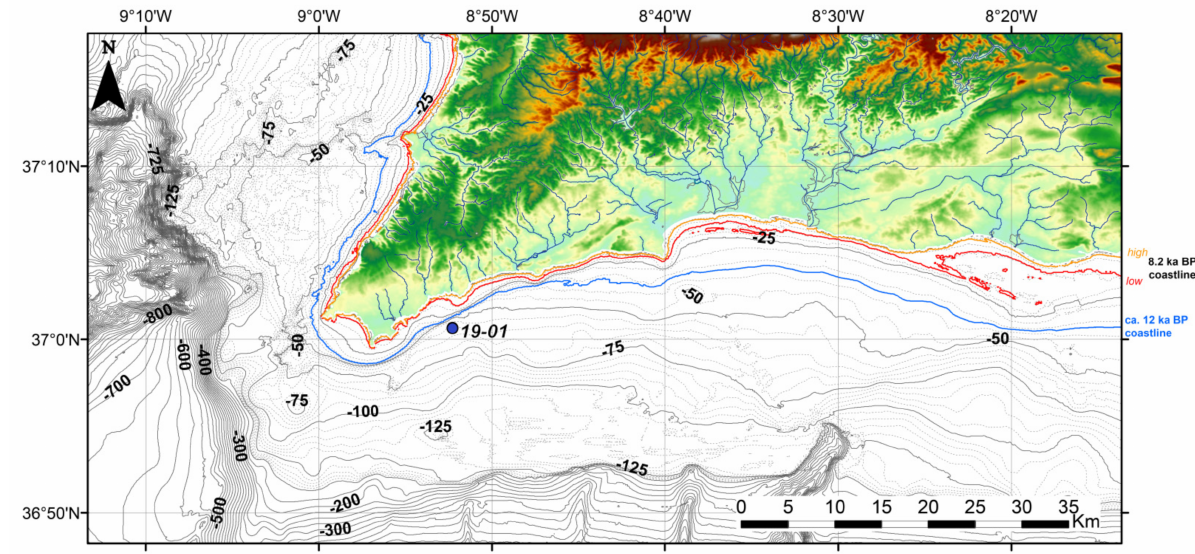
Figure 8. Digital terrain model map and bathymetry of the westernmost Algarve coast. Blue line indicates the coastline ca . 12 ka BP, red line shows the lowest possible coastline ca . 8. 2 ka BP, and yellow line situates the highest possible coastline ca . 8.2 ka BP. Blue dot represents the core 19-01. (Data source for bathymetry: EMODnet, https://www.emodnet-bathymetry.eu/ (accessed on 14 March 2021), for elevation: EU-DEM v.1.1, https://land.copernicus.eu/imagery-in-situ/eu-dem/eu-dem- v1.1 (accessed on 14 March